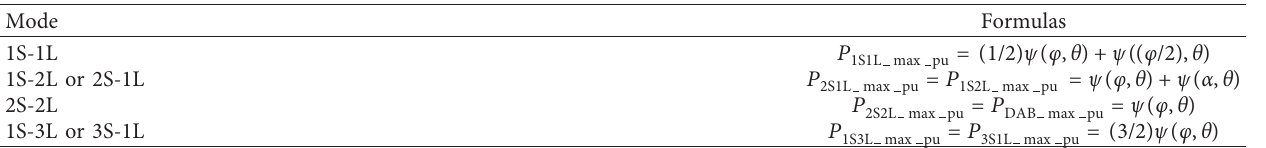
Figure 10: QP-M 2 DC maximum power operation mode. (a) 1S-1L, (b) 1S-2L, (c) 2S-1L, (d) 2S-2L, (e) 1S-3L, and (f) 3S-1L. Table 1: Formulas of maximum power in different working